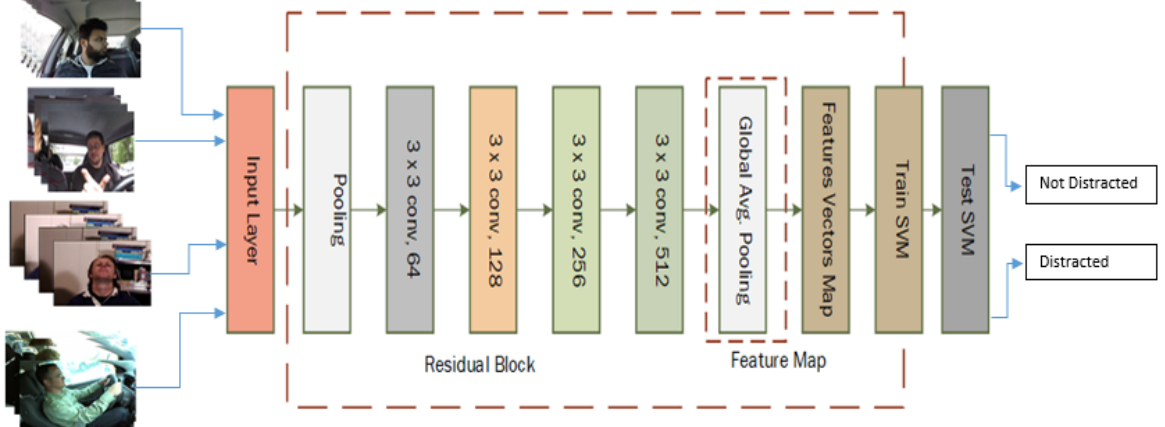
Figure 3. Flow chart showing the proposed